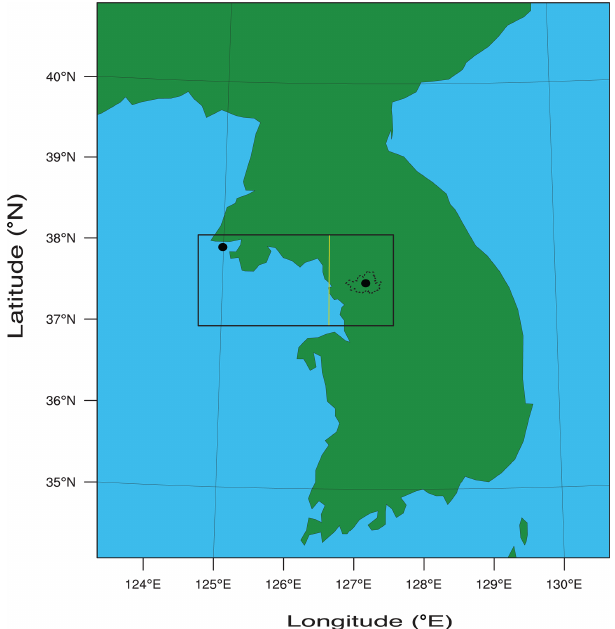
Figure 1. A rectangle represents the domain of interest in terms of the aerosol advection. A dot in the top left corner of the rectangle marks a station that measures PM 10 and PM 2 . 5 on Baekryongdo as detailed in Sect. 2. An area to the east of the yellow line in the rectangle is the Seoul area. In the Seoul area, a dot marks a repre- sentative station that measures PM 10 and PM 2 . 5 in the Seoul area as detailed in Sect. 2. A closed dotted line marks the boundary of the Seoul city.